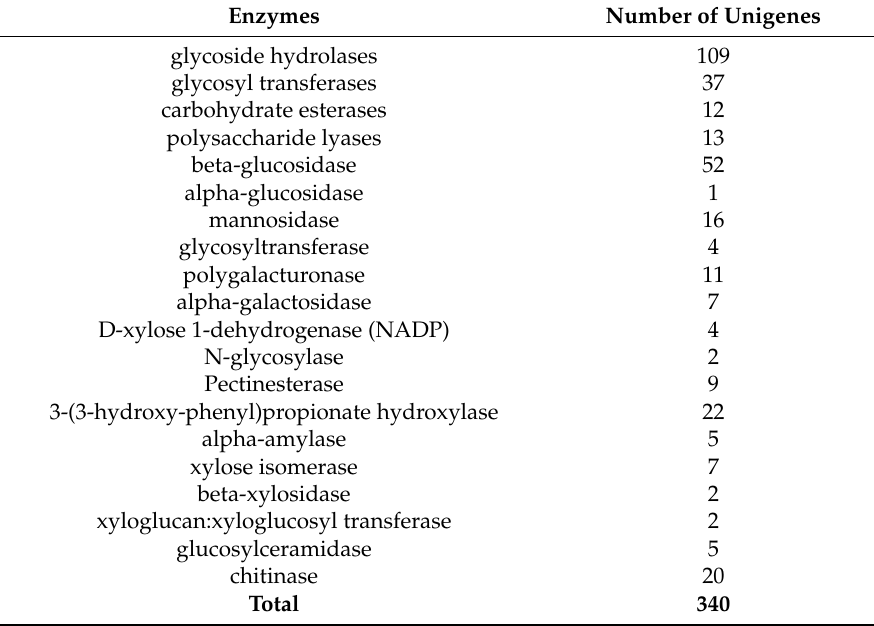
Table 3. Putative wood-degrading genes in the P. betulinus transcriptome. Enzymes Number of